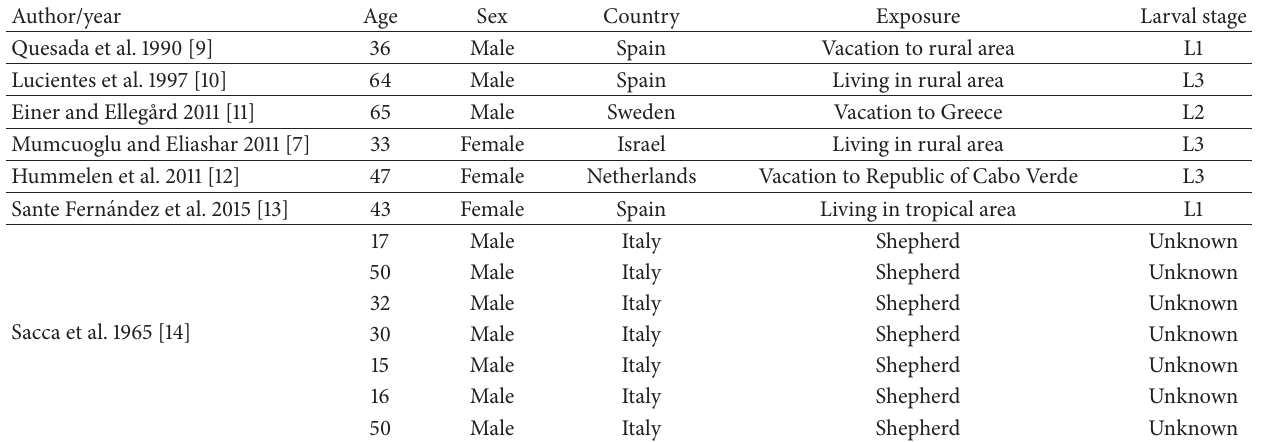
Table 1: Human cases of nasal myiasis caused by Oestrus ovis reported in the